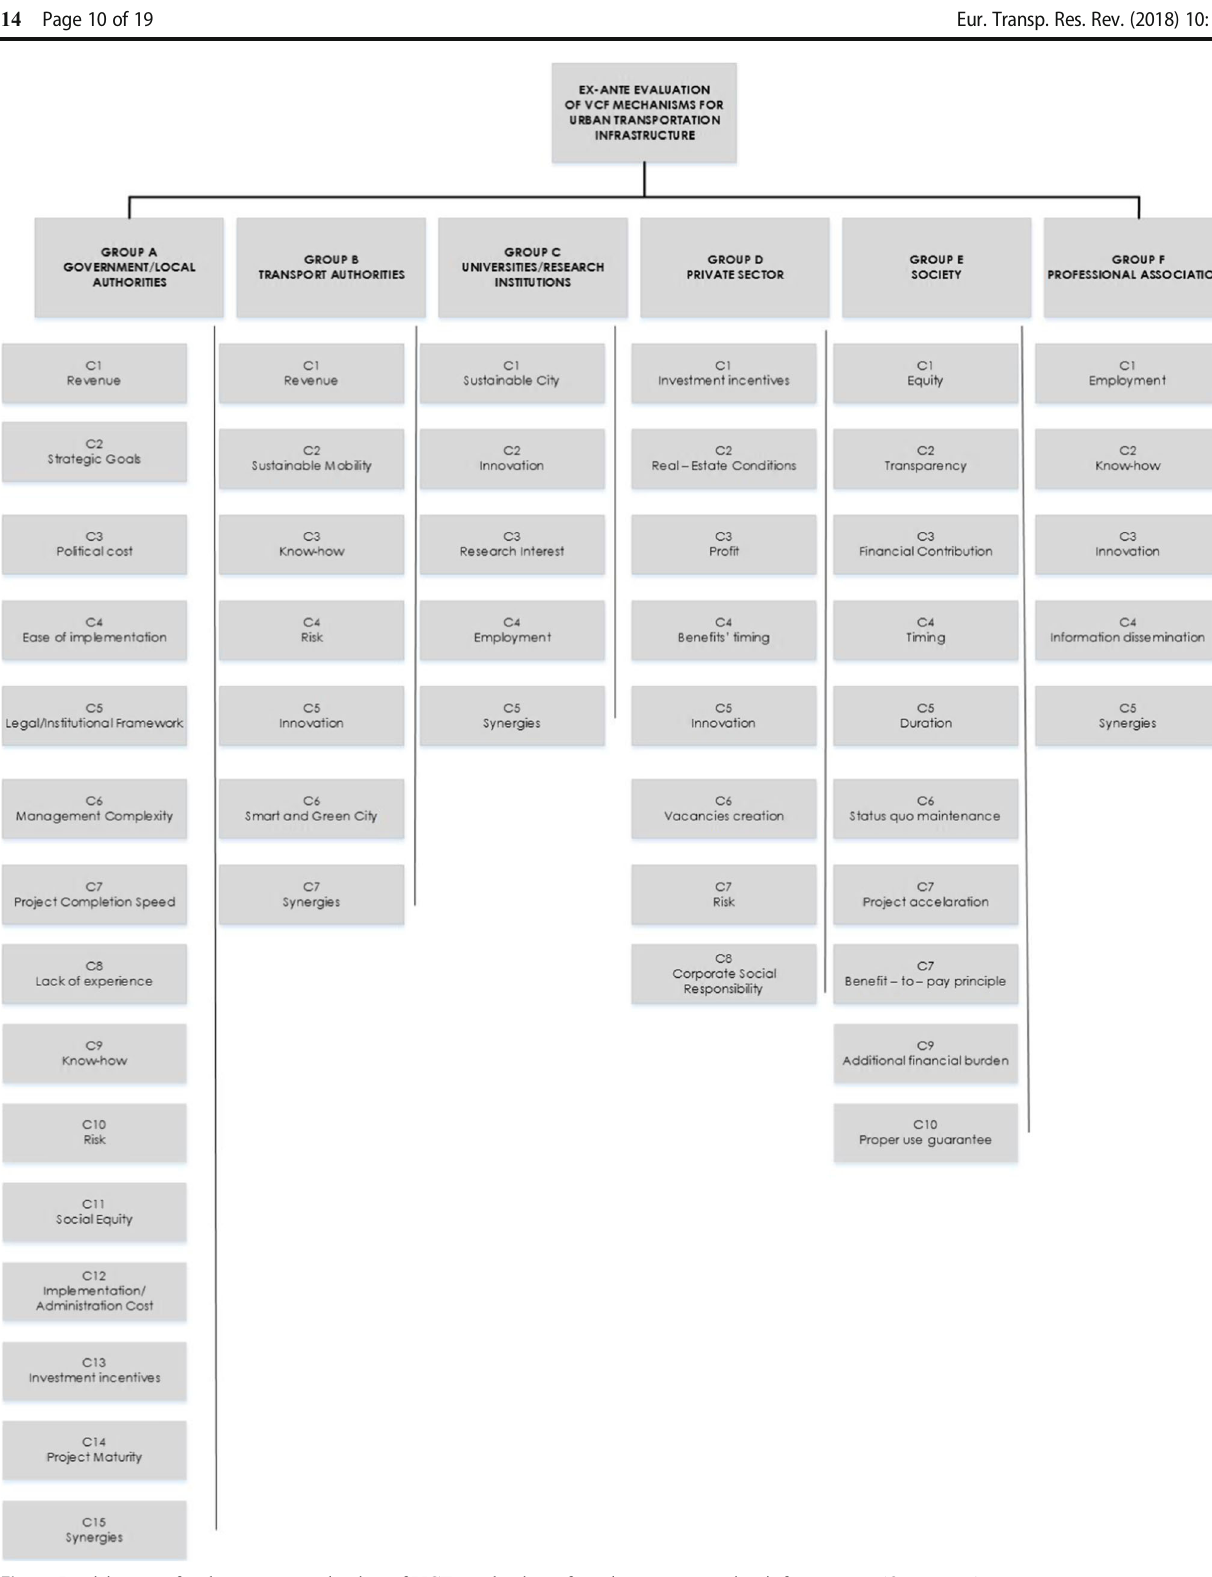
Fig. 3 Decision tree for the ex-ante evaluation of VCF mechanisms for urban transportation infrastructure (Own